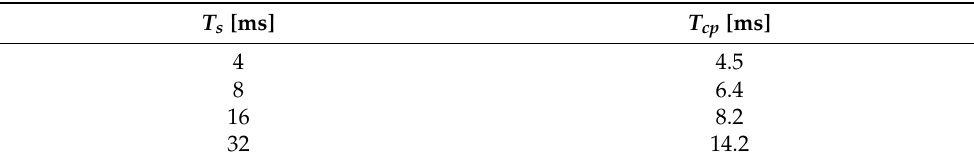
Table 9. Averaged calculation times T cp versus signal duration T s , obtained using the clock signal MCLK = 16